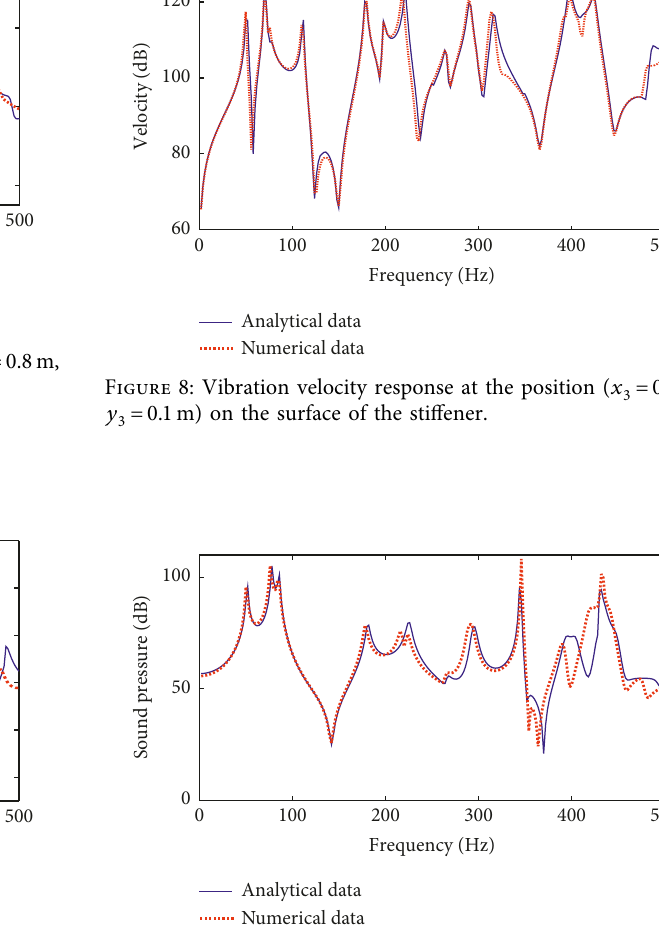
Figure 9: Sound pressure response at the position ( x � 0.2m, 2 y a � 0.3m, and z a � 0.4m) in the acoustic cavity a